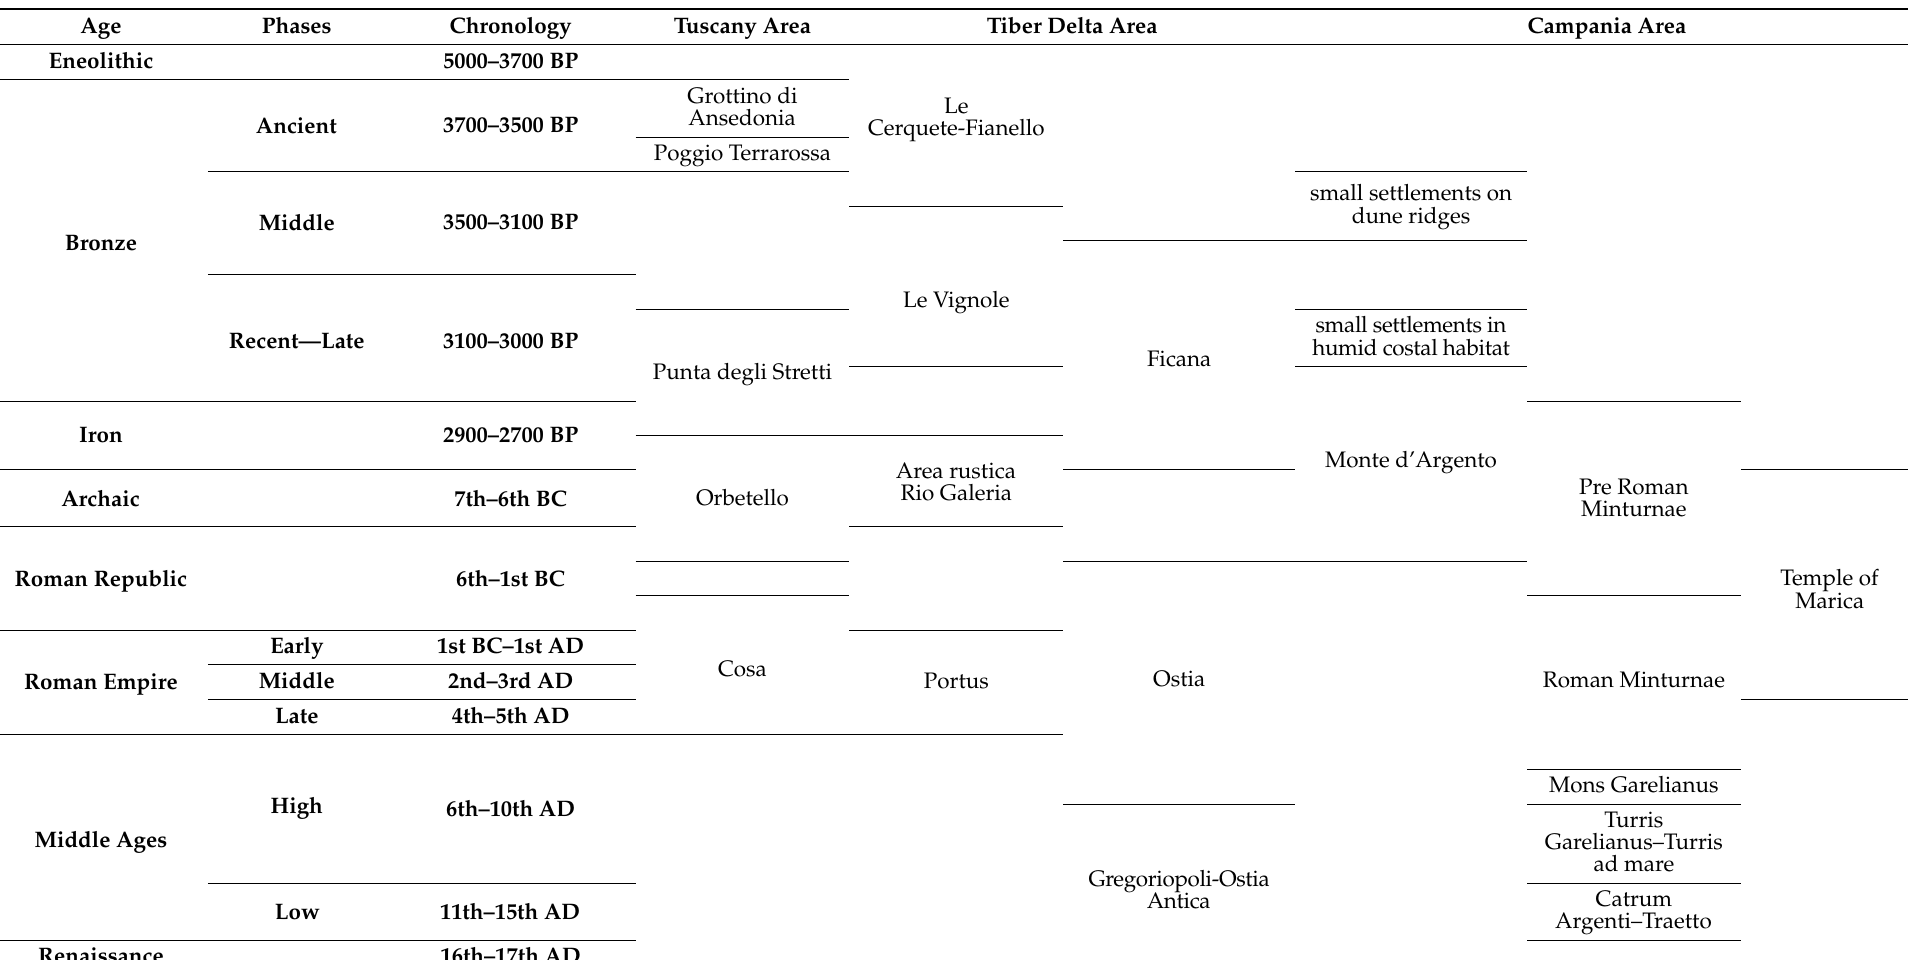
Table 2. Chronology of the protohistoric/historical ages and life span of the main settlements mentioned in the text. The Greek Gothic War took place between 535 and 553 AD. The Etruscan civilization started in the ninth century